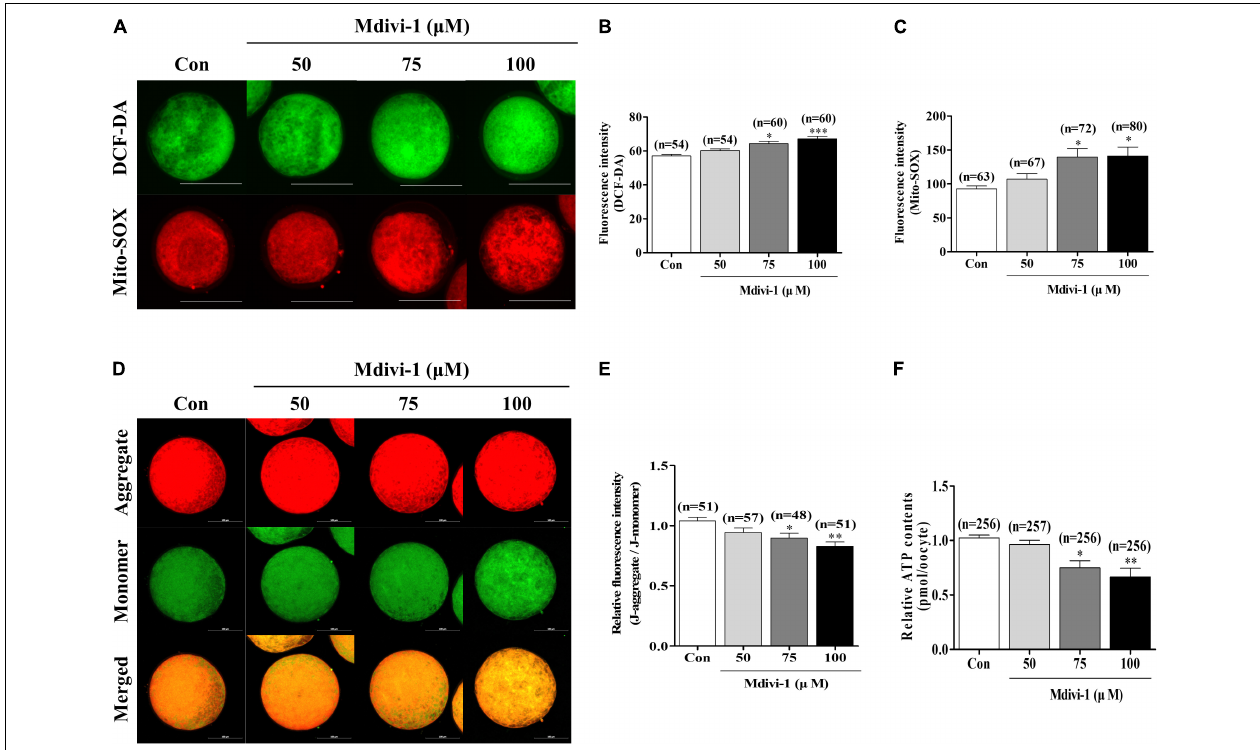
FIGURE 3 | Effects of mitochondrial division inhibitor 1 (Mdivi-1) exposure on mitochondrial functions in mature porcine oocytes. (A–C) Representative images of intracellular and mitochondrial reactive oxygen species (ROS) levels in control, 50, 75, or 100 µ M Mdivi-1-treated oocytes. Green: intracellular ROS; red: mitochondria-derived superoxide. Scale bar: 200 µ m. (D,E) Typical images of mitochondrial membrane potential (MMP) in the control and Mdivi-1 (50, 75, and 100 µ M) groups. Scale bar: 100 µ m. (F) Relative ATP contents of mature porcine oocytes from various Mdivi-1-treated groups. Data in the bar graph represent the mean ± SD of three independent experiments ( ∗ p < 0.05; ∗∗ p < 0.01; ∗∗∗ p <